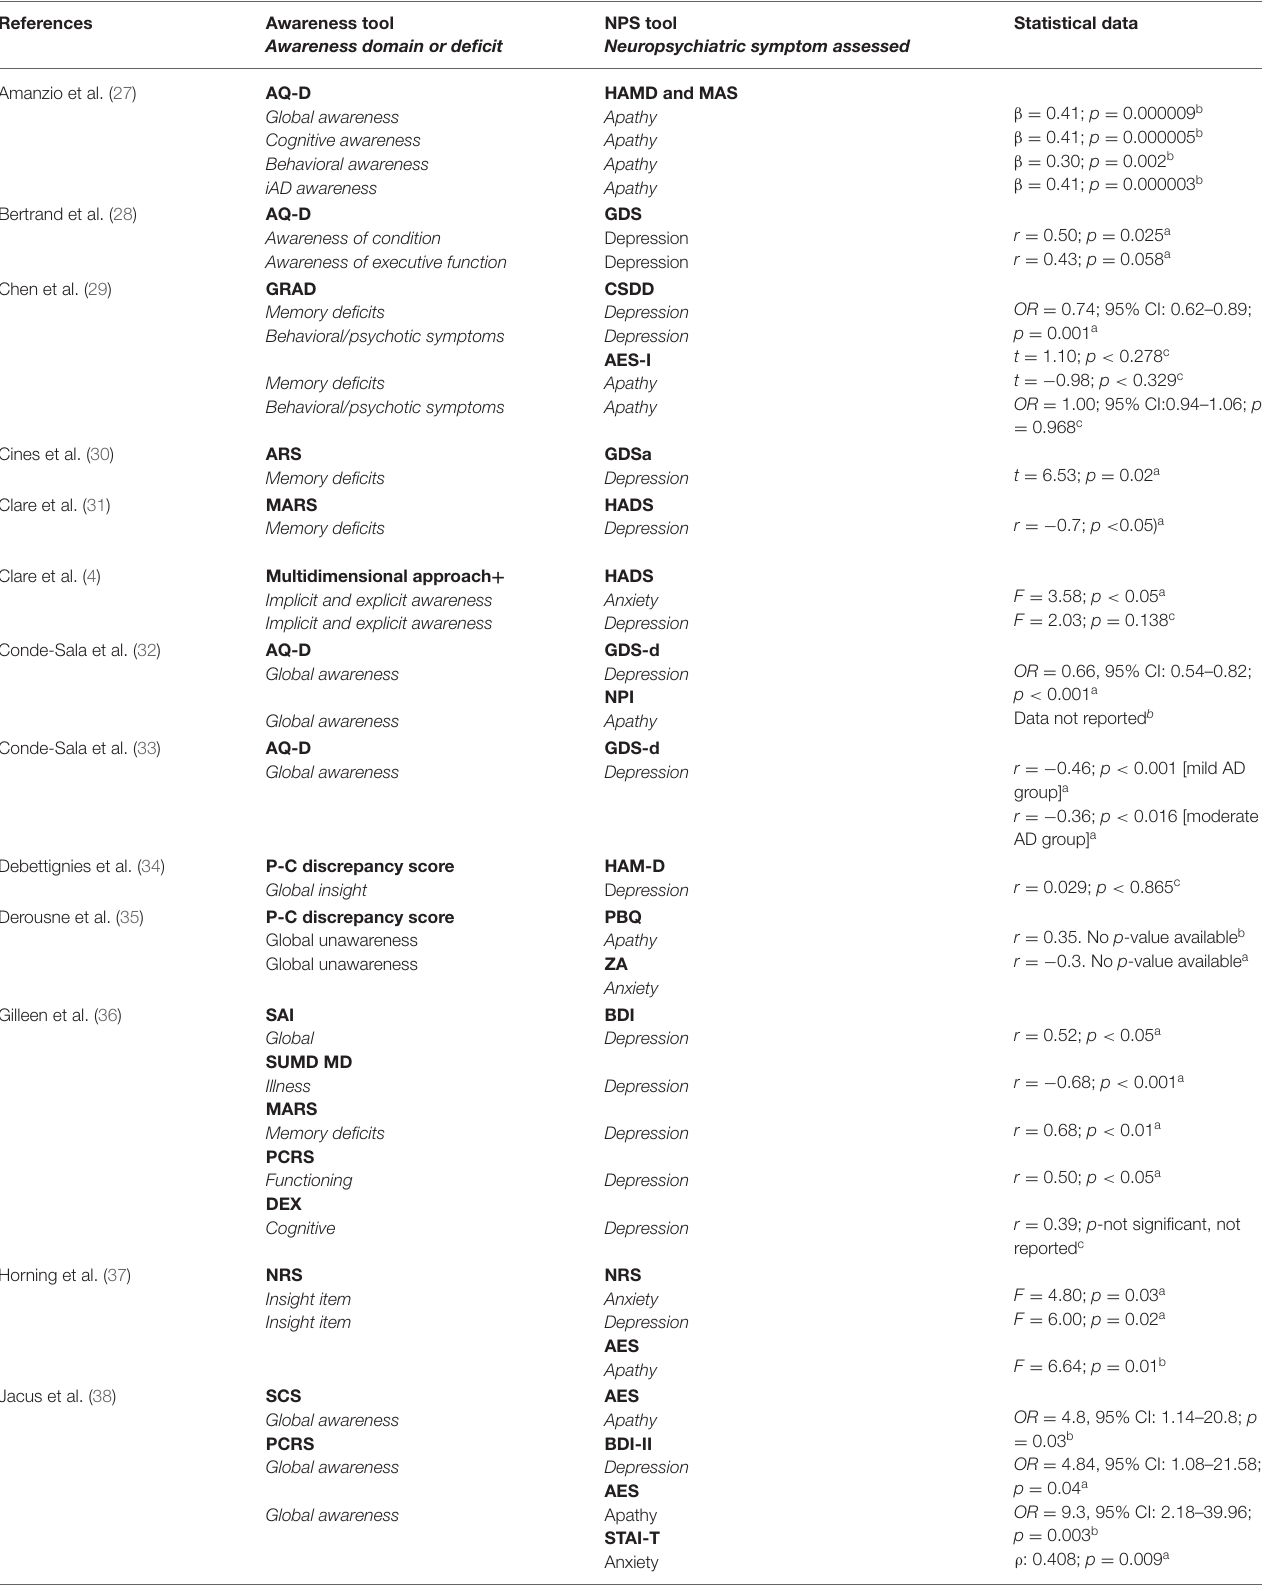
TABLE 2 | Results: association between impaired awareness and depression, anxiety, and apathy; data and summary of